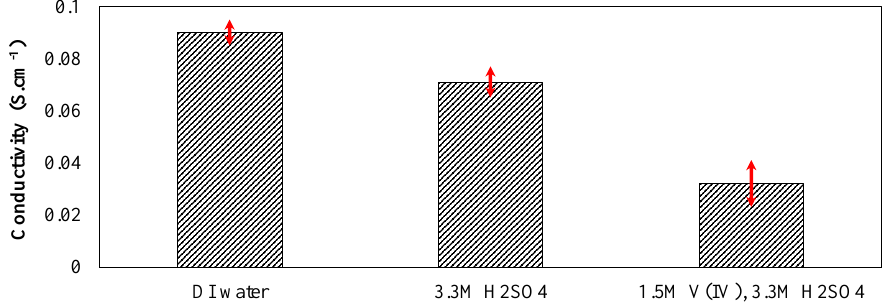
Figure 4. In-plane ionic conductivity of Nafion ® 115 equilibrated in different